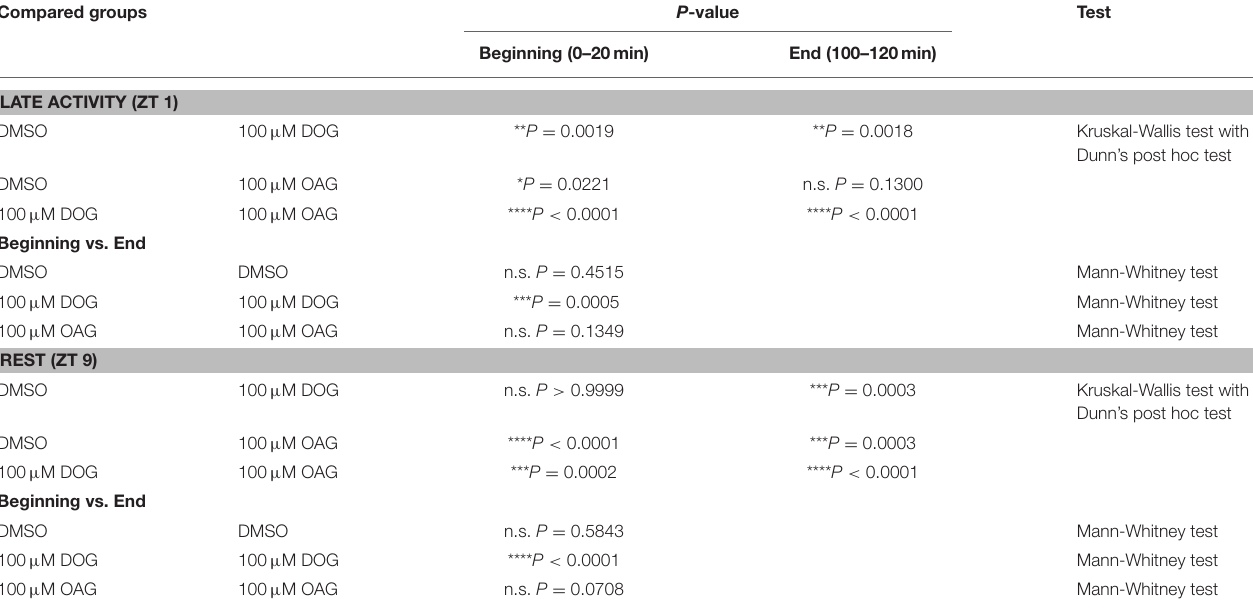
TABLE 3 | Statistical analysis of the AP frequency in the presence or absence of 100 µ M DOG or OAG during the late activity phase and at rest ( Figure 4 ). Compared groups P